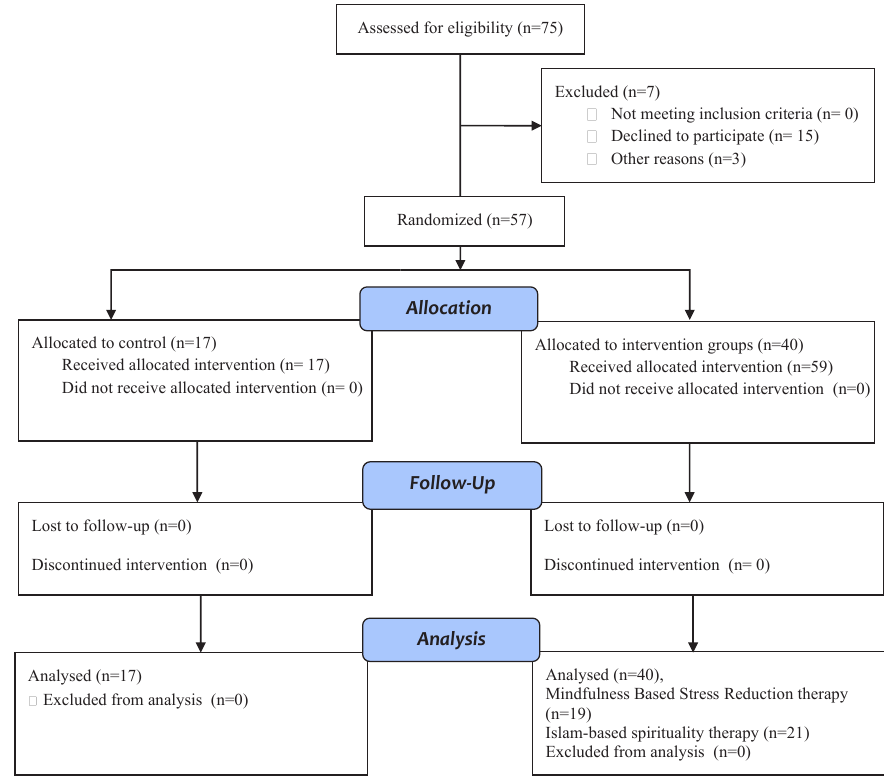
Figure 1. CONSORT flow diagram of the study